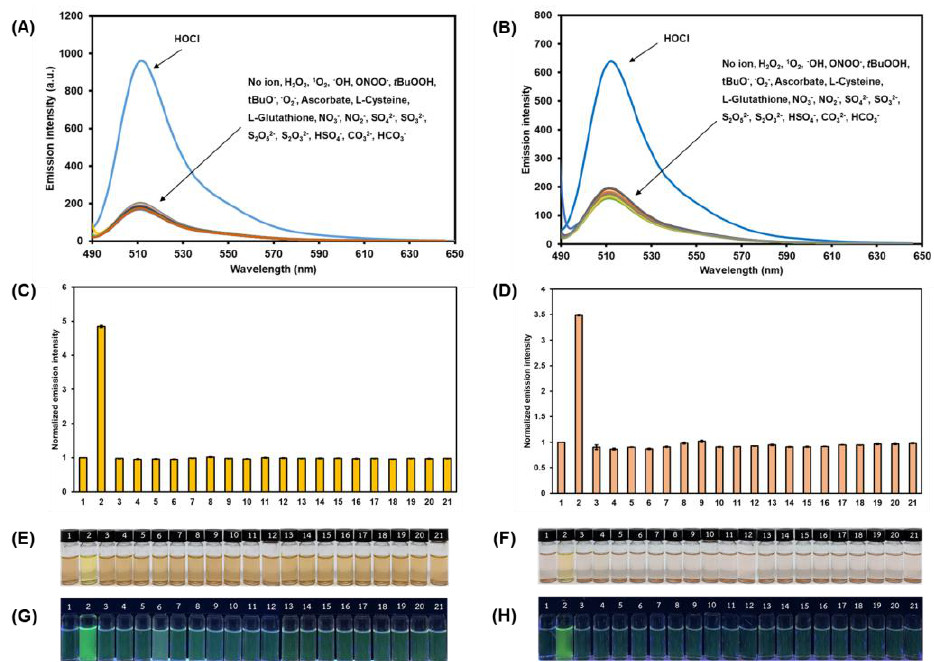
Figure 5. Emission spectra of compound 2 ( A ) and compound 3 ( B ) in the presence of various analytes in MeOH — 5 mM PBS (1:1 v/v ). Bar charts demonstrating fluorescence intensities at 512 nm of compound 2 ( C ) and compound 3 ( D ) in the presence of various analytes. Comparison of the color of BODIPY solutions (compound 2 ( E ) and compound 3 ( F )) and the visual emission under UV light (compound 2 (G) and compound 3 ( H )) in the presence of various analytes. [BODIPYs] = 0.2 µM, [Analytes] = 40 µM. 1: blank, 2: HOCl, 3: H 2 O 2 , 4: 1 O 2 , 5: OH, 6: ONOO - , 7: t BuOOH, 8: t BuO , 9: O 2 − ,